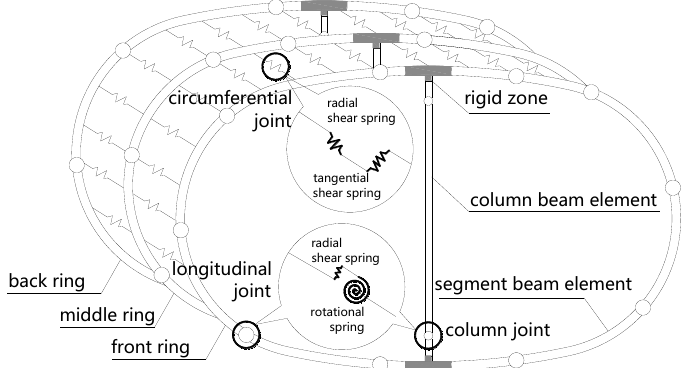
Figure 3. Beam-spring model of the quasi-rectangular shield tunnel linings.